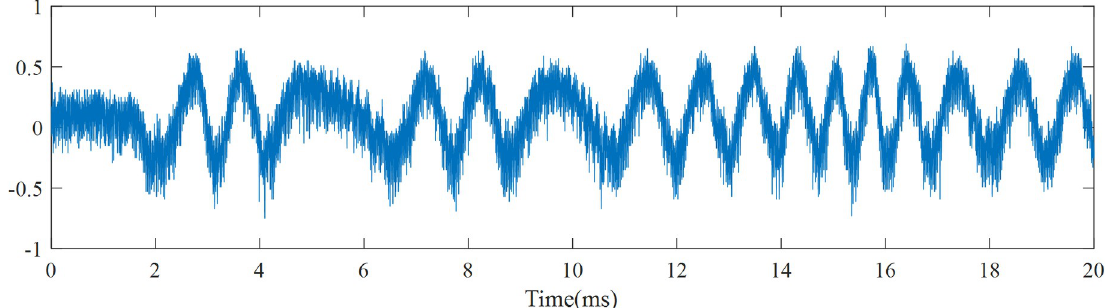
Fig 3. Waveforms of the laser interference signal.